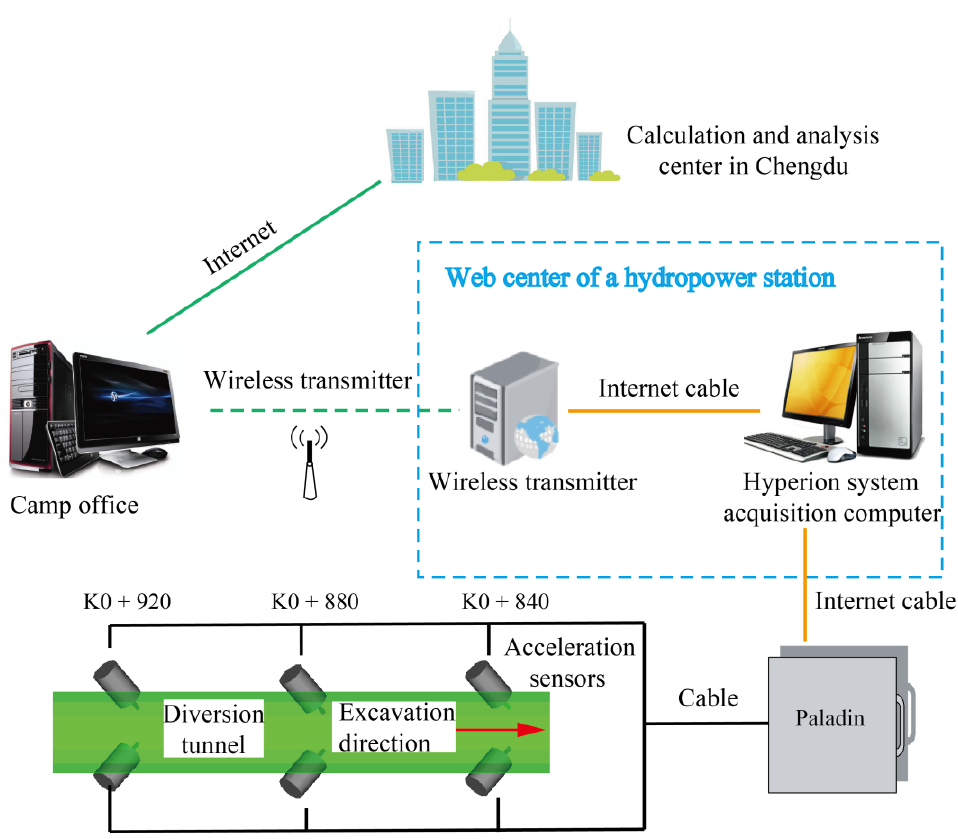
Figure 3. Topology diagram of the microseismic monitoring system in the diversion tunnel of the hydropower station.